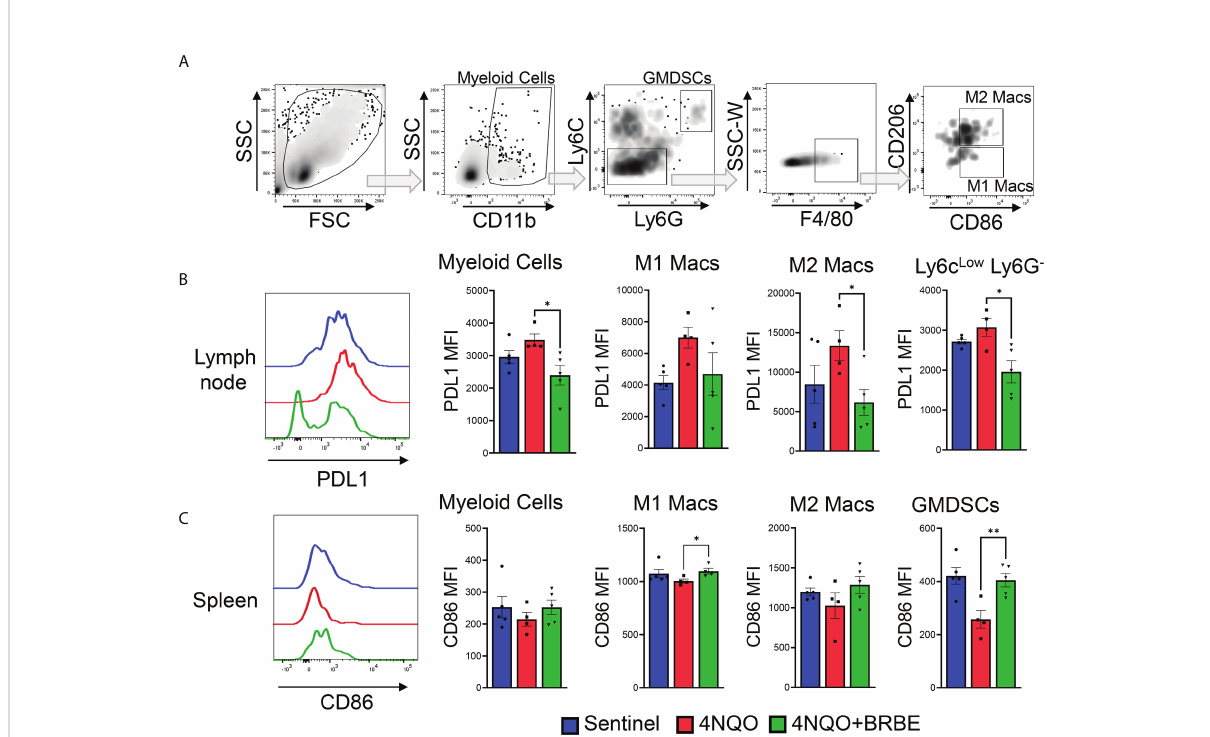
FIGURE 5 Impact of black raspberry extract on myeloid cell populations involved in immune response to HNSCC. (A) Flow cytometric gating strategy used to de fi ne CD11b + , CD11b + Ly6G - Ly6C - , CD11b + Ly6G + Ly6C hi , F4/80 + CD206 - , and F4/80 + CD206 + cell populations within all analyzed tissues. (B) Representative fl ow cytometric histogram plots of PD-L1 + CD11b + cells. Bar graphs of PD-L1 expression cells on myeloid cells, M1 and M2 macrophages, and Ly6c low Lg6G - myeloid cell populations in the lymph nodes of non-carcinogen-induced mice (sentinel), and carcinogen- induced mice fed the control AIN76 diet (4NQO) or the BRB-E-supplemented diet (4NQO+BRB-E). Data are presented as mean fl uorescence intensity (MFI). (C) Representative fl ow cytometric histogram plot of CD86 + M1 macrophage population in the spleens of each mouse group. Bar graphs of CD86 + cells from myeloid cells, M1 and M2 macrophages, and GMDSC cell populations in the spleens of non-carcinogen- induced mice (sentinel), and carcinogen-induced mice fed the control AIN76 diet (4NQO) or the BRB-E-supplemented diet (4NQO+BRB-E). Data are presented as mean fl uorescence intensity (MFI). * p -value < 0.05; ** p -value < 0.01 for comparisons of BRB-E treatment groups to the 4NQO-exposed control diet group using Student ’ s t